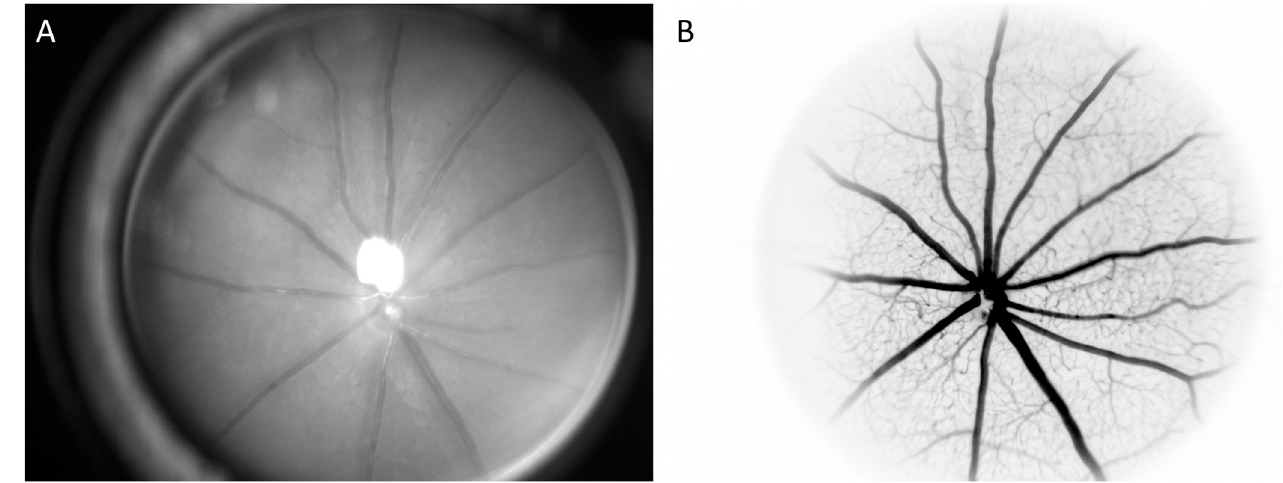
Fig 1. Fundus images of one mouse without and with fluorescein. Retinal vessels of one mouse without (A) and with fluorescein (B).